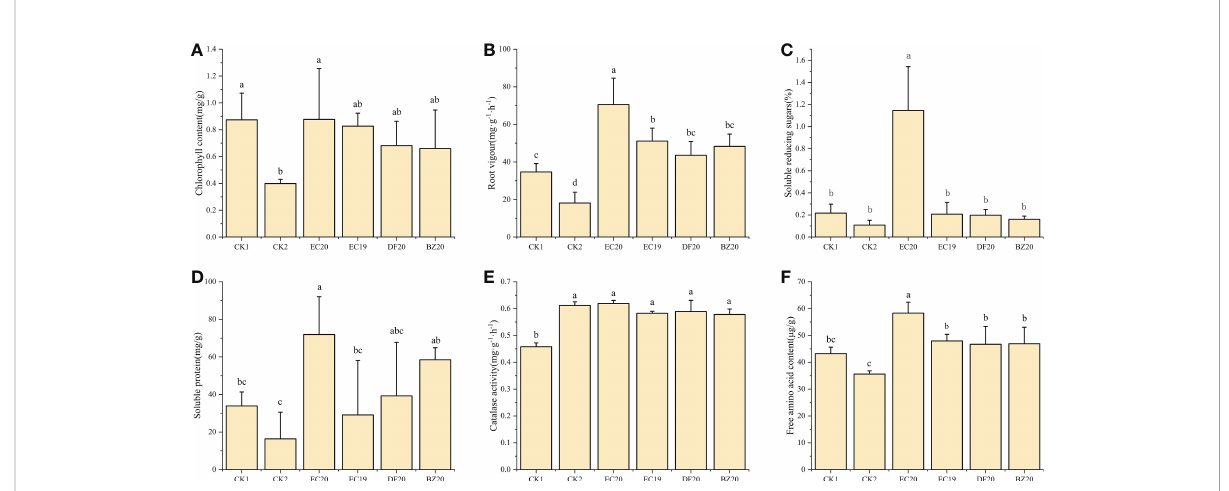
FIGURE 5 Effect of biofertilizer on physiological and biochemical indicators of cowpea: (A) chlorophyll content; (B) root vigor; (C) soluble reducing sugars; (D) soluble protein; (E) catalase activity; (F) free amino acid content. Data represent the mean ± SD of at least three independent experiments, and different lowercase letters indicate that differences between different treatment groups reached signi fi cance at the P<0.05